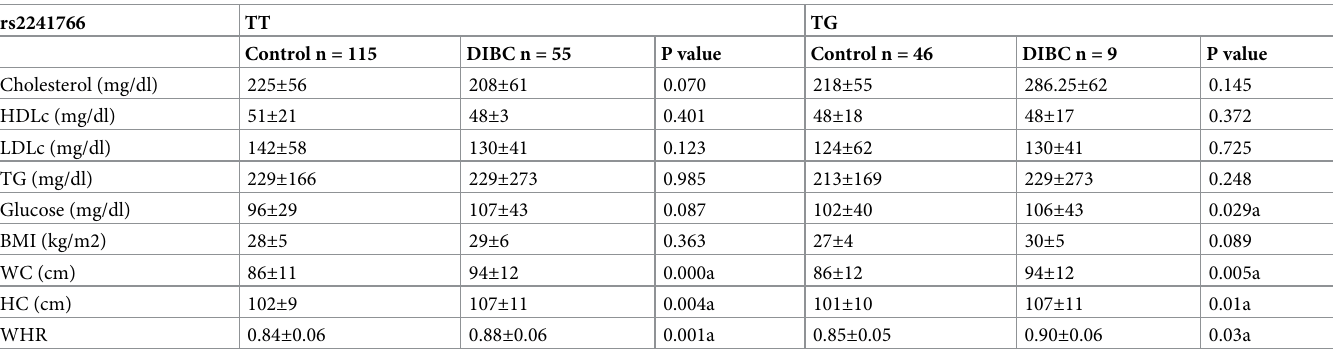
Table 3. Comparison of corporal composition measures and biochemical determinations with rs2241766 genotypes.